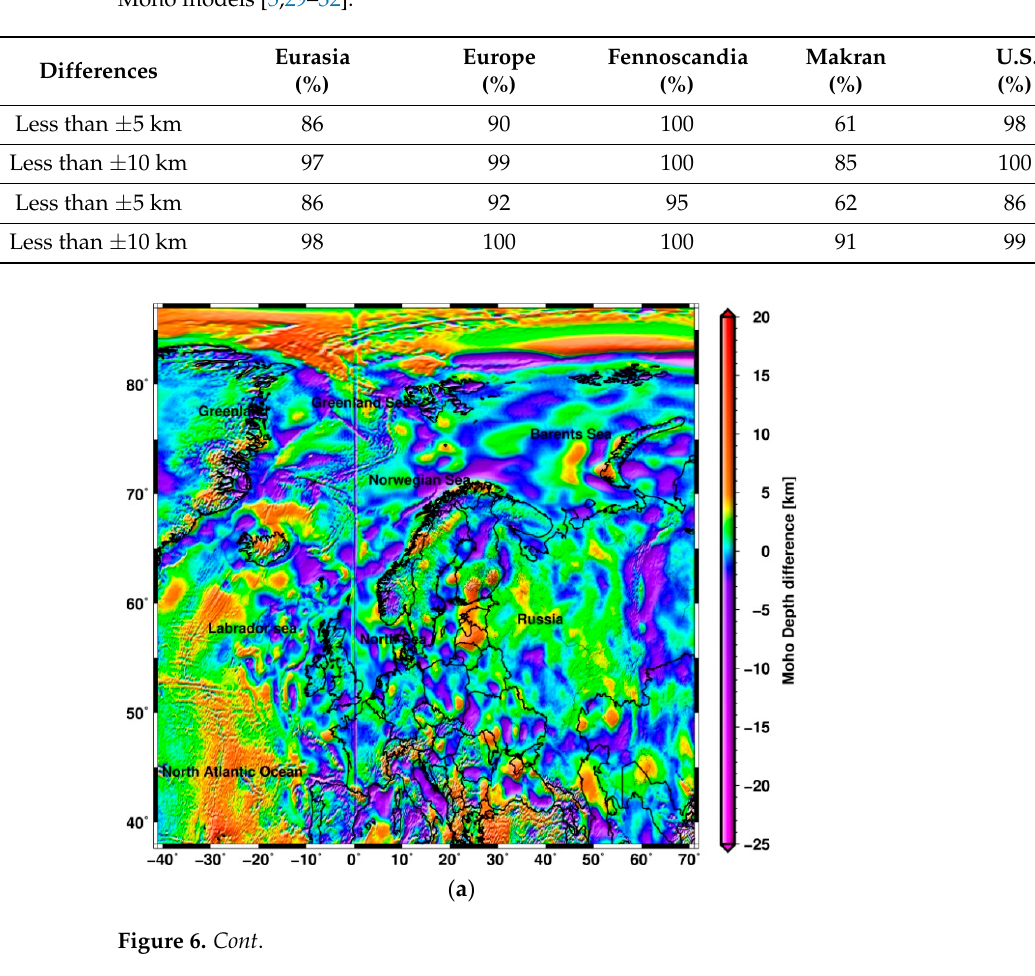
Figure 5. The Moho depth differences between ( a ) the HRCM Butterworth filter solution and the Eurasian Moho model [5] and ( b ) the HRCM spectral combination solution and the Eurasian Moho model [5]. Unit: km. Table 3. Statistics of the HRCM Moho depth differences with respect to the continental and regional Moho models [5,29–32].